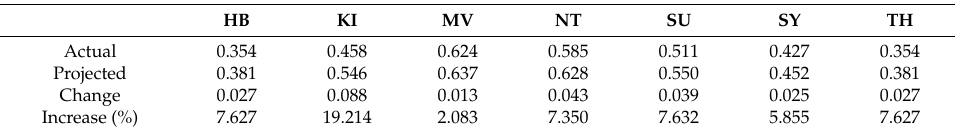
Table 15. Poverty rate in flash flood region in Bangladesh.